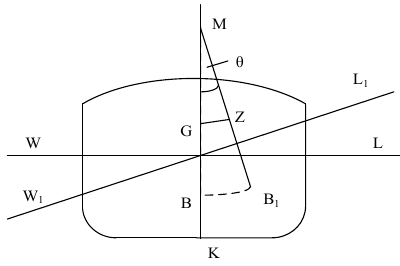
Figure 1. Ship stability factors.